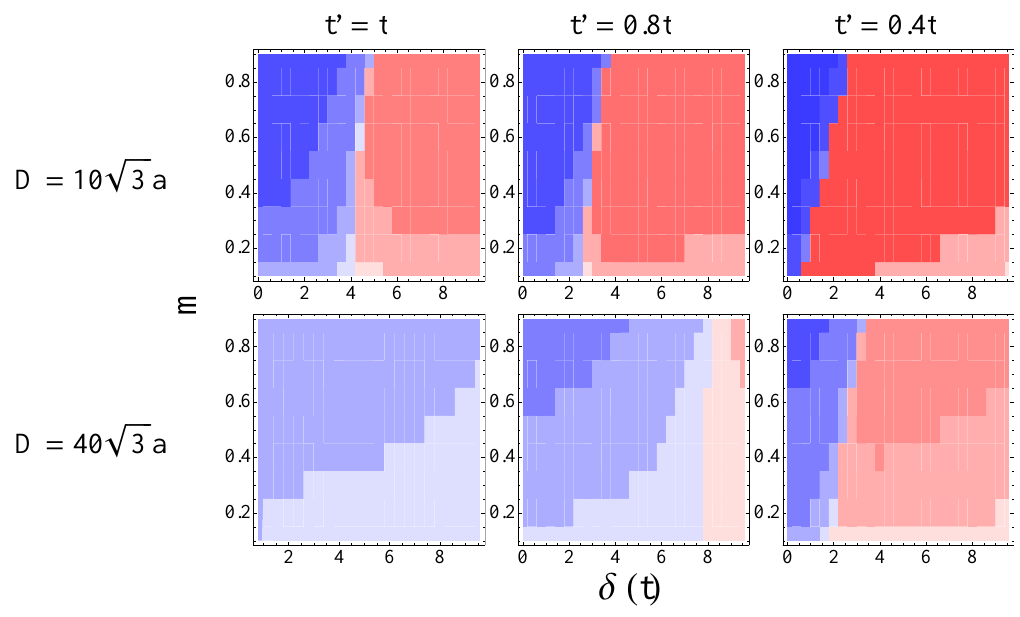
Each diagram represents an area of ( m, δ ) phase space with ferromagnetic (antiferromagnetic) couplings given by a blue (red) shading that is darker for larger magnitude couplings. The diagrams √ a between the magnetic moments and from left to right on the top row correspond to a separation of 10 show the cases of t ′ = 1 . 0 t, 0 . 8 t, 0 . 4 t . The bottom panels show the same cases for a larger separation of √ 40 a . By examining the border between the blue and red regions in these plots we can infer under what circumstances the sign-change behaviour described above occurs. In all cases the border position varies only weakly with the magnetic moment ( m ) or hence the band-splitting ( V ). A stronger dependence ex is found on the band-centre shift ( δ ) and we find that, in general, an anti-ferromagnetic alignment is found above a critical value of δ . The band-centre shift is strongly dependent on the occupation of the magnetic orbital. For a bipartite lattice like graphene a substitutional impurity with a half-filled orbital gives zero band-centre shift when t ′ = t . As we move away from half-filling a larger band-centre shift is required to return the correct band occupation. For smaller values of t ′ we note that the border between the blue and red regions shifts towards the left, meaning that smaller band-centre shifts will lead to an AFM alignment. Increasing the distance between the impurities reduces the phase-space area corresponding to an AFM alignment by shifting the border to the right and requiring larger band-centre shifts. This finding agrees with the distance-dependent plots in Figure 5 for fixed parameters which show that in the asymptotic limit the coupling changes sign and returns the FM alignment predicted by the RKKY approximation. However, as in the bottom panel of Figure 5, the magnitude of the coupling has essentially decayed to zero before the sign change occurs so the only significant